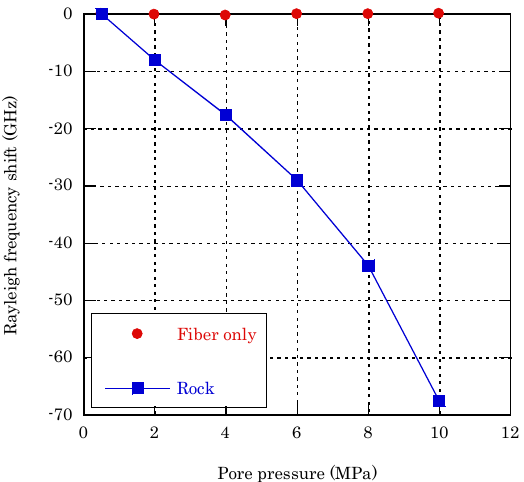
Figure 10. Berea core Rayleigh frequency shift measurements in comparison with the baseline values (sensor region B).